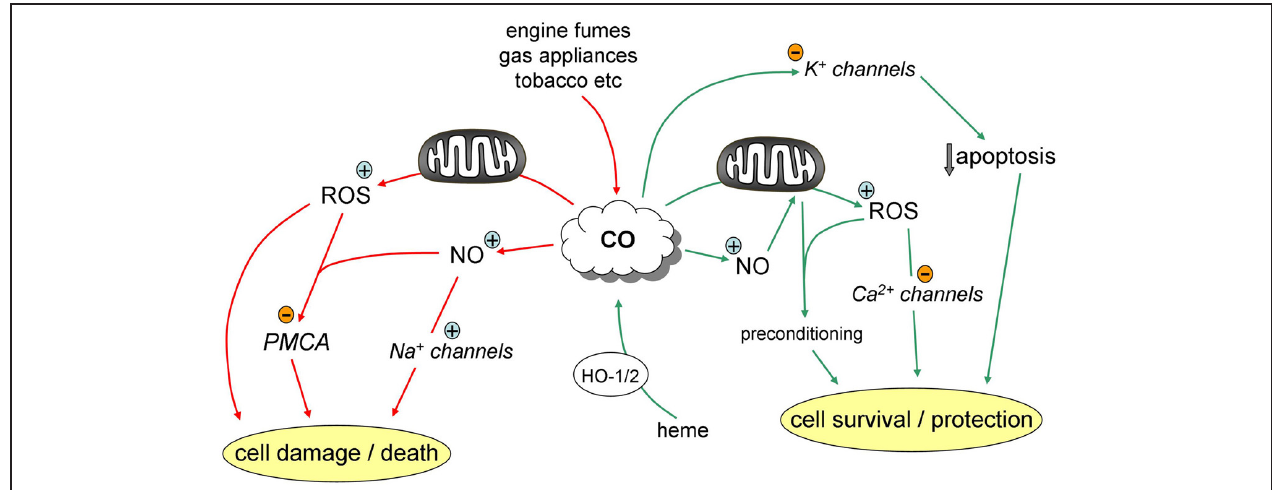
FIGURE 1 | Pathways contributing to the protective (green) and deleterious (red) effects of